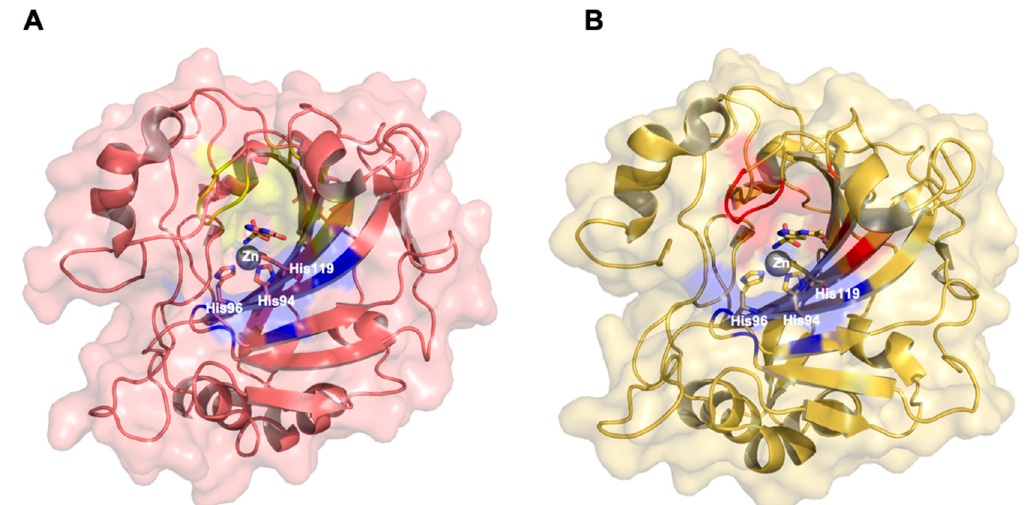
Figure 4. Crystal structure of CA VII and CA XIV in complex with ACZ. ( A ) The ACZ chelates, together with the three conserved His, Zn 2+ in the catalytic site of CA VII. Hydrophobic residues are colored in yellow, while hydrophilic residues are colored in blue (pdb 3ML5). ( B ) The ACZ chelates, together with the three conserved His, Zn 2+ in the catalytic site of CA XIV. Hydrophobic residues are colored in red, while hydrophilic residues are colored in blue (pdb 4LU3).